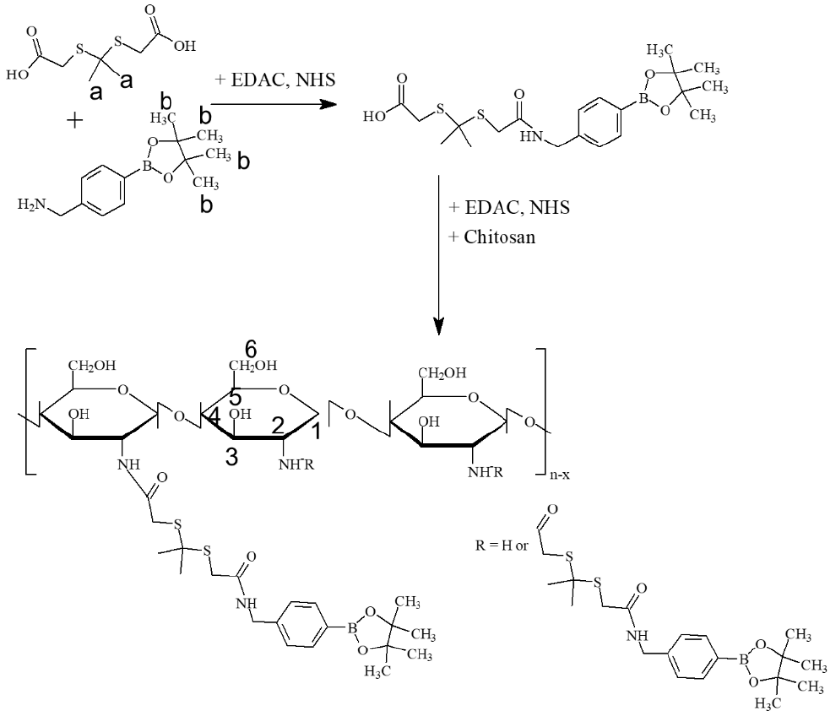
Figure 1. Synthesis scheme of COSthPBAP conjugates. “a” indicates the methyl groups of the ThdCOOH; “b” indicates the methyl groups of the PBAP. The numbers of “1–6” indicate te protons of carbon 1–6 of glucose in